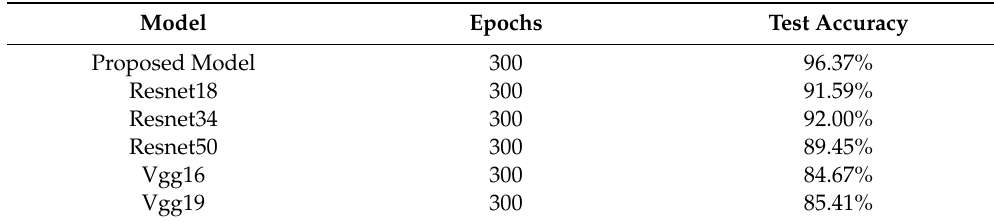
Table 1. Model comparison.